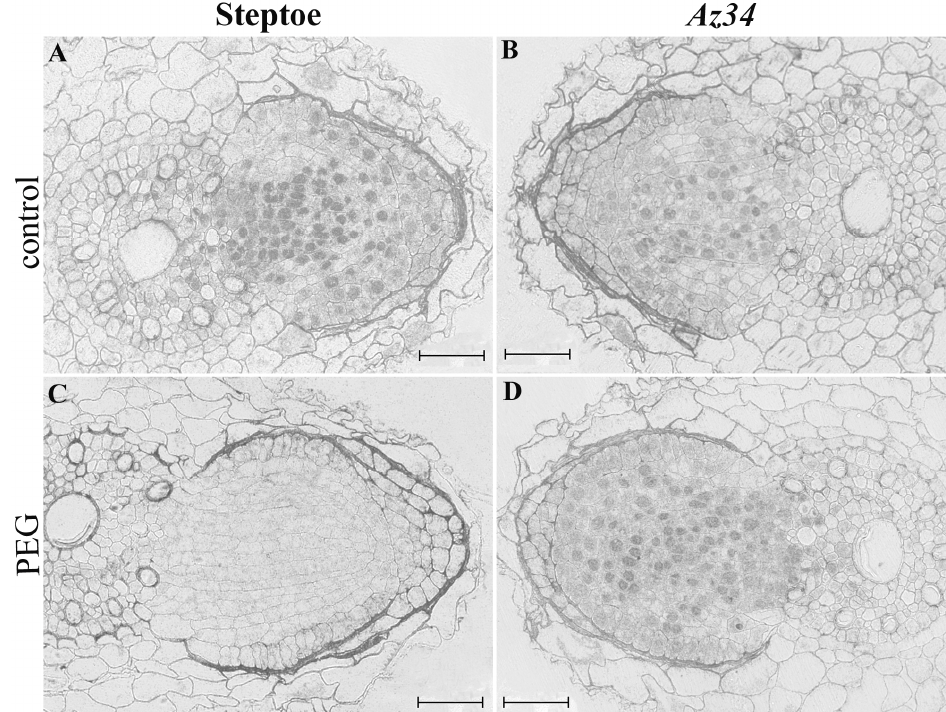
Figure 5. Effect of 6% polyethylene glycol (PEG) treatment on immunolocalization of IAA in the cells of root primordia of Steptoe (A, C) and Az34 (B, D) plants; A, B—plants grown under normal conditions; C, D—stressed plants. Scale bar is 50 µm.